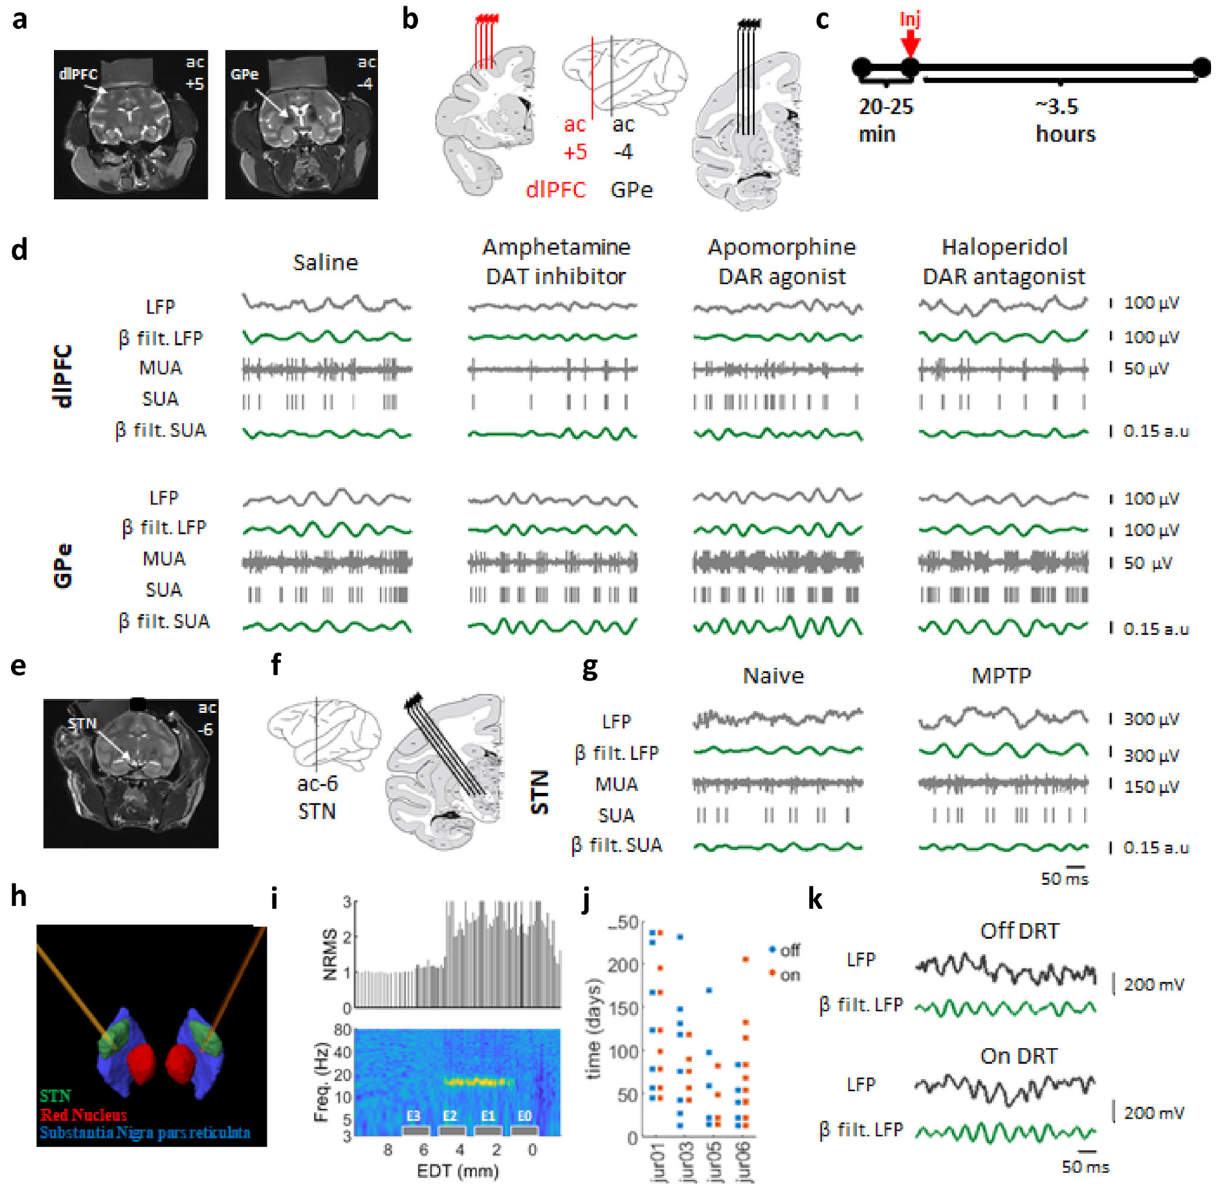
Fig. 1 Experiment design. a MRI of monkey-G. Coronal images showing recording targets. b A scheme of ac + 5 and ac − 4 coronal planes with four electrodes in each recording target. Middle: coronal plane positions marked on an atlas scheme (Martin and Bowden 22 ; http://braininfo.rprc.washington.edu/copyright.aspx). c Daily timeline scheme with pre- and post-injection times. d 500ms traces from the dlPFC and GPe under each drug condition. LFP: local fi eld potential, MUA: multi-unit activity, SUA: single-unit activity (top: cortical narrow units, bottom: pallidal units), β fi lt: beta (8 – 24Hz) bandpass fi ltered. e , f , g Same as a , b , d of monkey K STN. i Electrode position marked on a reconstruction of one patient atlas, based on the post-op CT with the pre-op MRI. i Electrode contact position relative to STN electrophysiological activity of the same patient as in h . x -axis indicates estimated distance from target (EDT). The target was set preoperatively close to the imaging based ventro-lateral border of the STN. Top: MUA total power evaluated as normalized root mean square (NRMS). NRMS elevation and decline indicate STN entry and exit, respectively. Bottom: Recti fi ed MUA normalized power spectral density (nPSD, percentage of total power, fi ltered with a Gaussian window for presentation purposes). Contact positions marked as gray boxes. The STN dorsolateral motor area can be identi fi ed according to its pronounced beta activity. j Recording schedule of PD patients included in this study. k 500ms traces from the STN of PD patient (same patient as in h – i ) on and off DRT. DAT: dopamine transporter, DAR: dopamine receptor. dlPFC: dorsolateral prefrontal cortex, GPe: globus pallidus pars externa, STN: subthalamic nucleus, DRT: dopamine-replacement